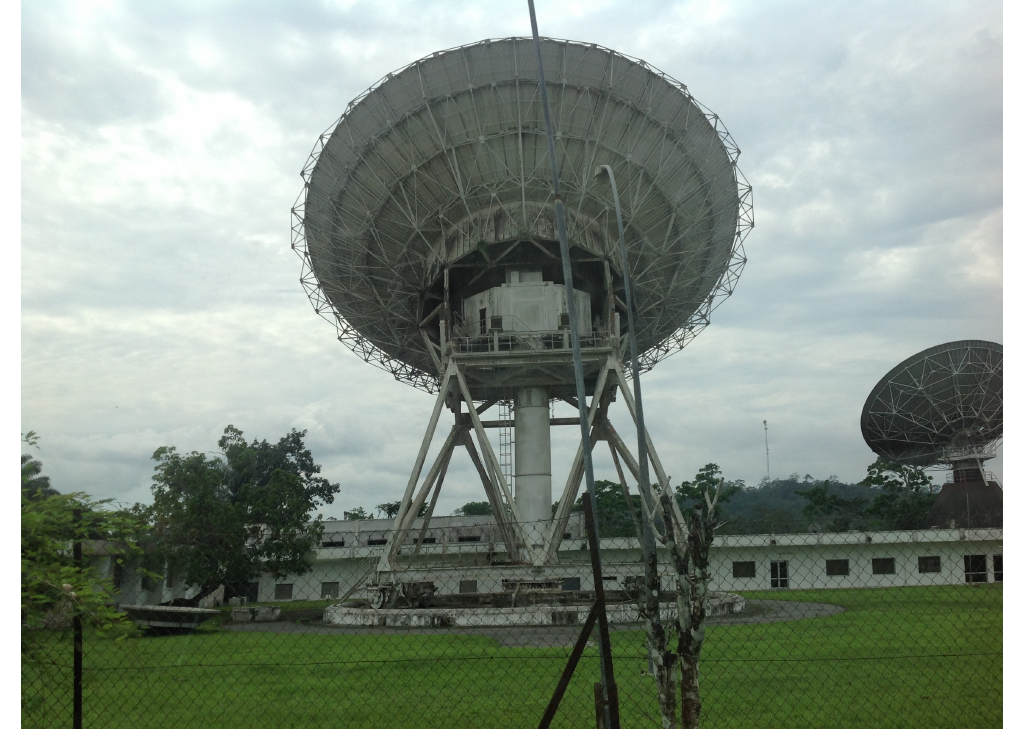
Figure 1. Decommissioned 32-m large satellite earth station antennas in